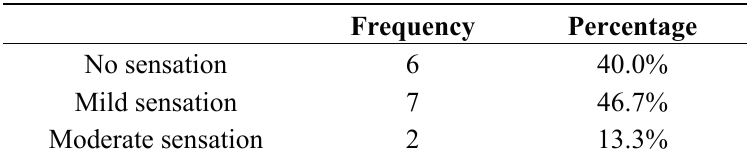
Table 4. Z axis motion